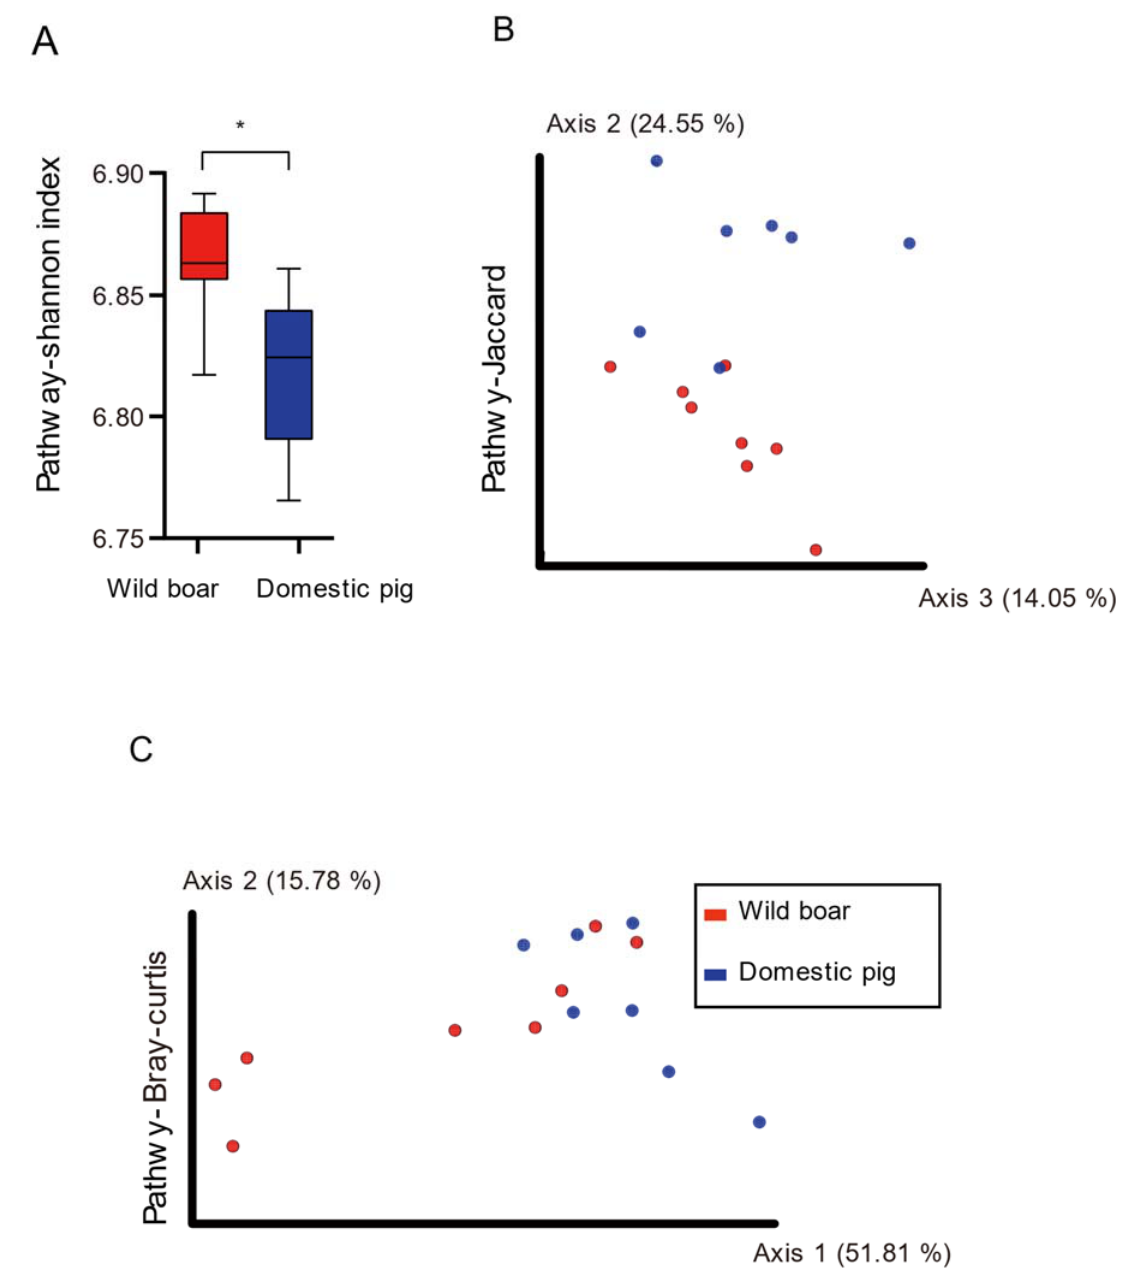
Figure 5. The alpha and beta diversity of KEGG pathways between wild boars and domestic pig Alpha diversity in Shannon index ( A ), * p < 0.05, Mann–Whitney U-test. Red and blue bars represent wild boars and domestic pigs, respectively. ( B ): Principal Coordinate Analysis (PCoA) of pathway based on Jaccard distances. ( C ): Principal Coordinate Analysis (PcoA) of pathway based on Bray– Curtis distances. ANOSIM, p < 0.05, red, blue circles represent bacterial communities of pigs in the wild boars and domestic pigs,